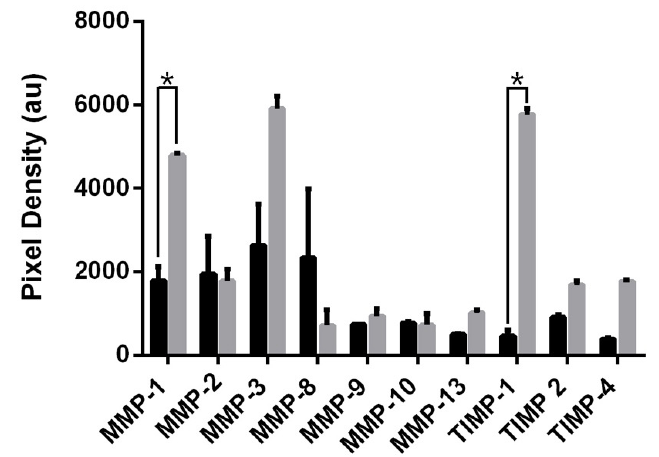
Figure 4. Mean pixel density of target proteins secreted into culture media by IL-6-induced MSCs at 3 h (black) and 24 h (grey) hour intervals. Culture medium was analysed using Abcam human MMP antibody array membranes, viewed on Agilent 2100 Bioanalyser, followed by quantification using ImageJ. Values analysed via t -test, * p < 0.005.